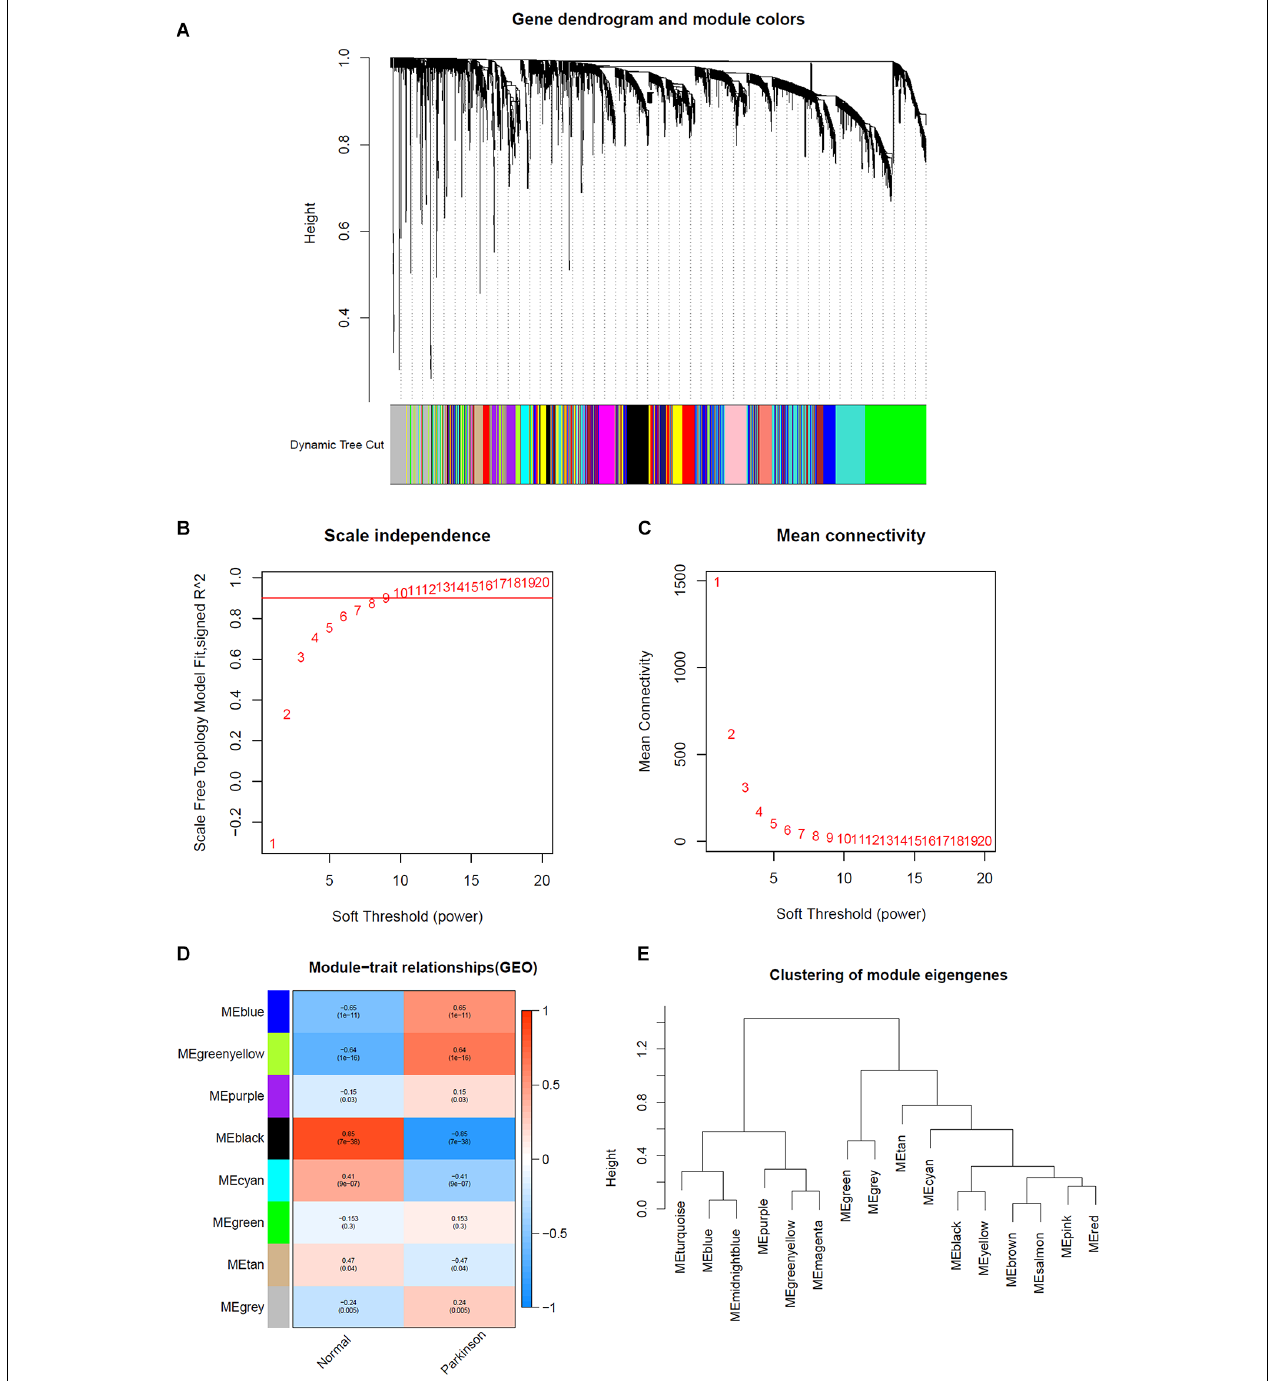
FIGURE 2 | Determination of soft-thresholding power in WGCNA analysis. (A) Dendrogram of all differentially expressed genes clustered based on a dissimilarity measure. (B) Analysis of the scale-free fit index for various soft-thresholding powers β . (C) Analysis of the mean connectivity for various soft thresholding powers. (D) Heatmap of the correlation between module eigengenes and clinical traits of Parkinson. (E) Clustering of module eigengenes. microdomain, synaptic vesicle, and membrane region. The binding, and protein transmembrane transporter activity. In addition, the results of the KEGG pathway analysis in the bubble most enriched molecular function (MF) annotations were chart revealed that DEGs were remarkably concentrated in the hormone receptor binding, dystroglycan binding, vinculin Viral myocarditis, Adherens junction, Arrhythmogenic binding, ATPase regulator activity, nuclear hormone receptor